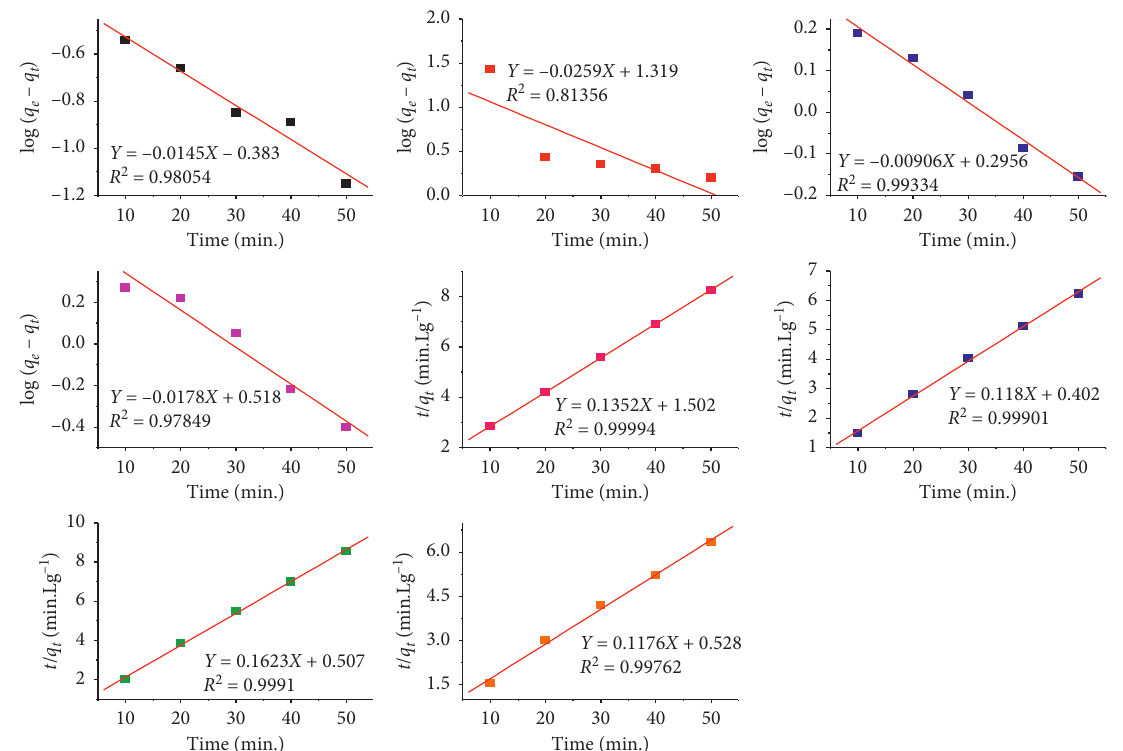
Figure 10: Pseudo-first-order (a) for ALAPW and (b) for RLAPW and pseudo-second-order (c) for ALAPW and (d) for RLAPW for the adsorption of MG dye at different contact time intervals.